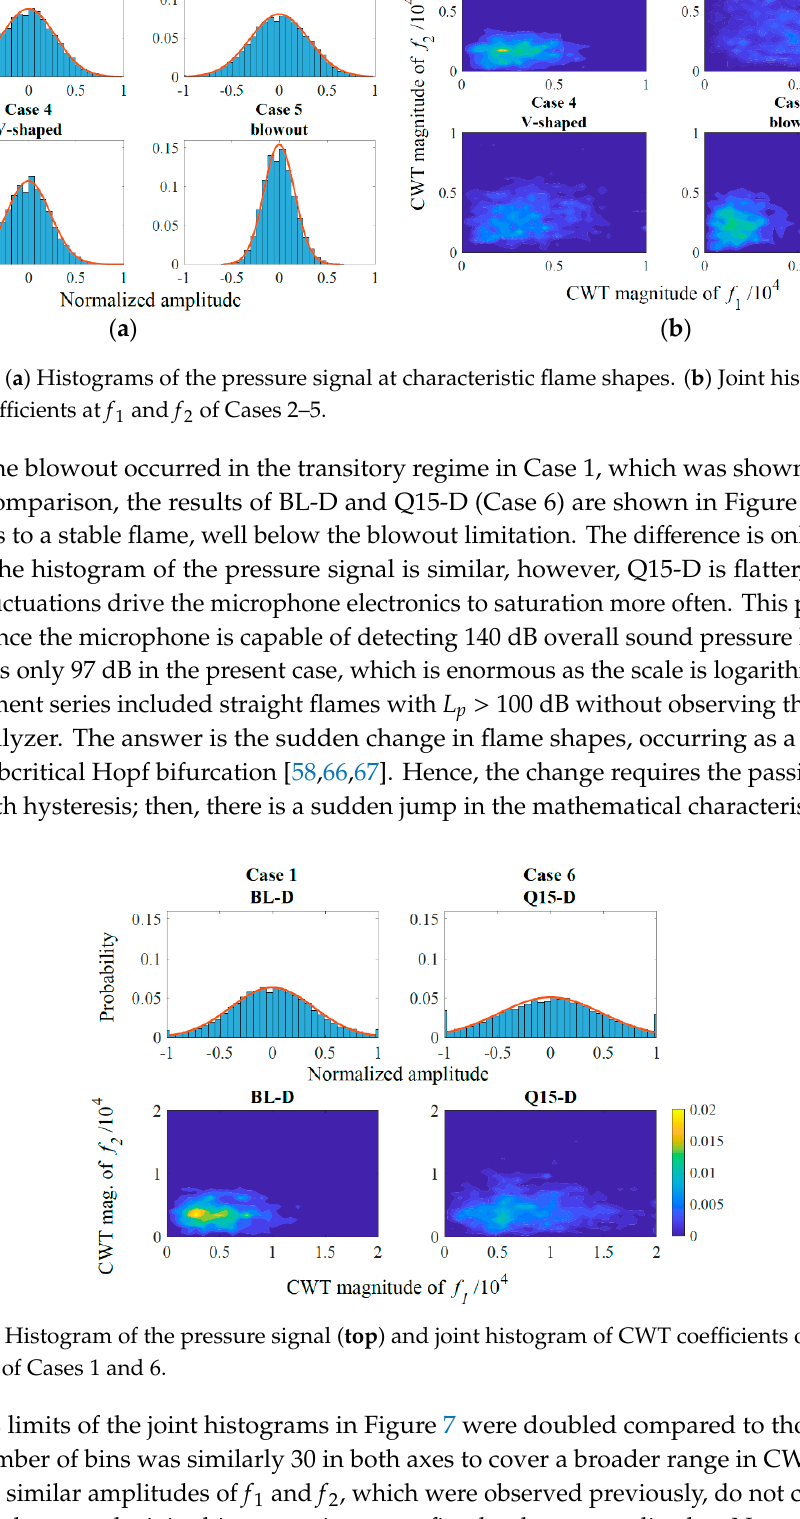
( b ) Figure 8. Combustion in V-shaped mode until blowout at p g = 0.3 bar and Q15-D: Cases 7–10. ( a ) Histograms of the pressure signal and ( b ) joint histograms of the CWT coefficients at f 1 and f 2 (bottom). Concluding from the results, either a shape parameter of a fitted PDF or the decreasing CWT coefficients at characteristic frequencies imply flame blowout. Nevertheless, the computational effort required for the former method is significantly lower. It is free from the selection of frequencies, which may be different for various burner configurations.